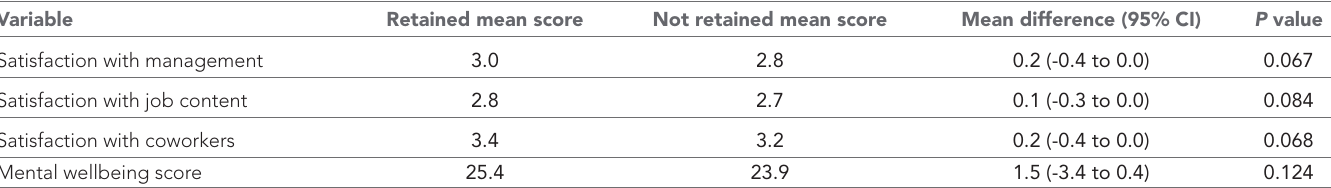
Table 4 Association between satisfaction with the work experience and mental wellbeing and retention